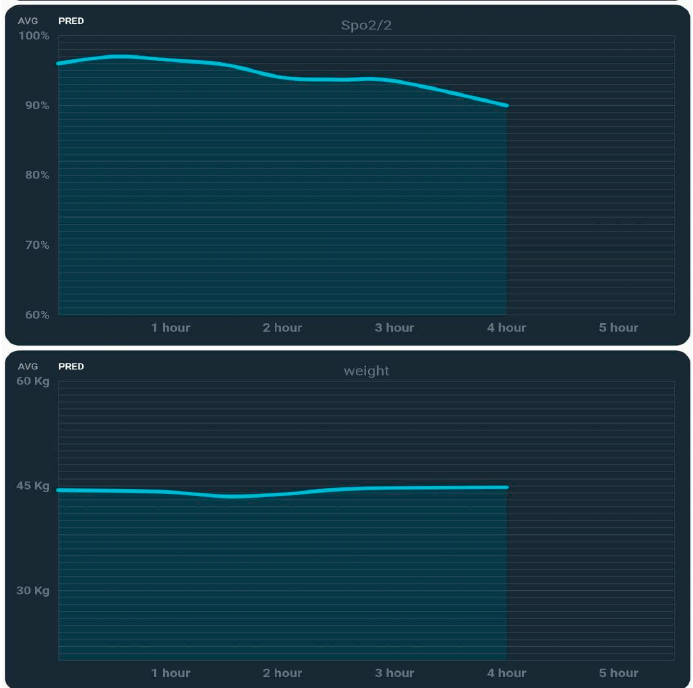
Figure 9. Force measurement from overall sacral region C.